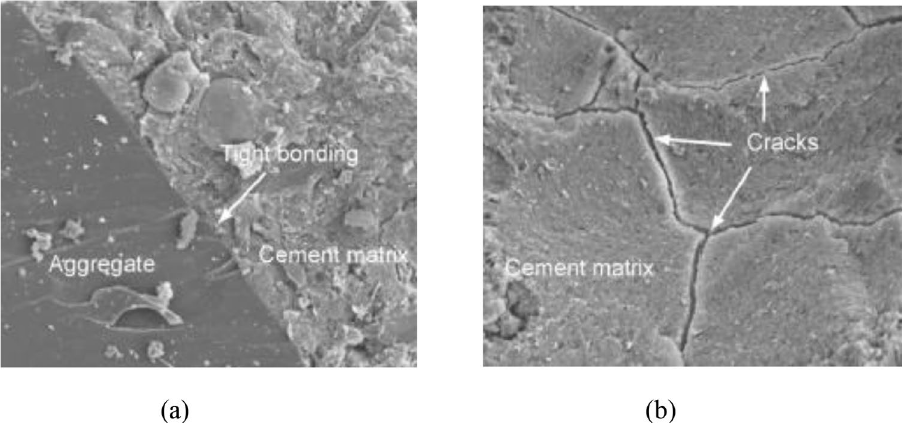
Figure 14. ( a , b ) SEM Images of control concrete.